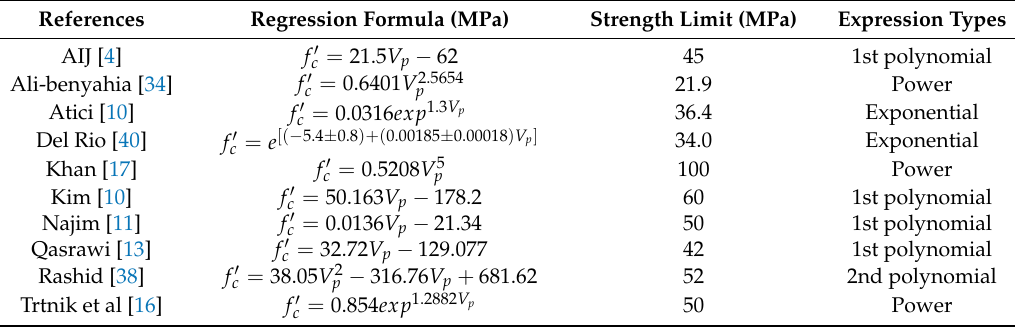
Table 5. Previous equations for the ultrasonic pulse velocity method.